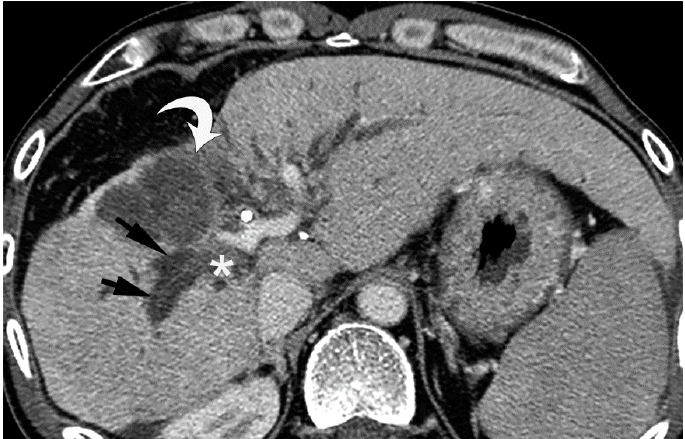
Figure 10. Equilibrium phase image of a contrast-enhanced CT of BDN. A hypodense tubular structure (arrows) is observed in the hepatic hilum of the right lobe. Enhancement of the right main portal branch is discontinued (*), which represents thrombotic obstruction of the portal vein caused by BDN. (Curved arrow is the biloma.).